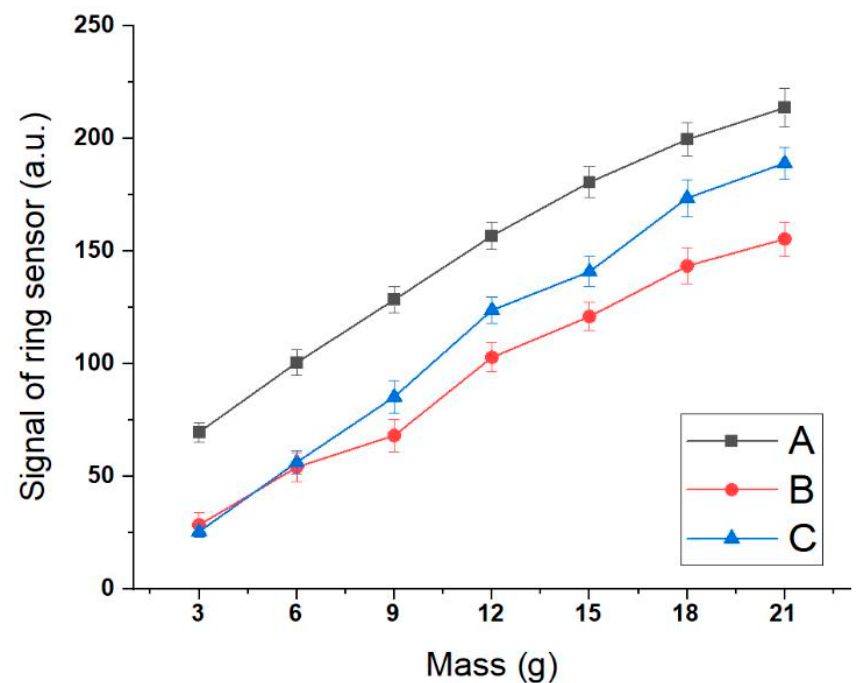
Figure 6. Correlation between the sensor signal and food mass on spoon using a ring sensor system